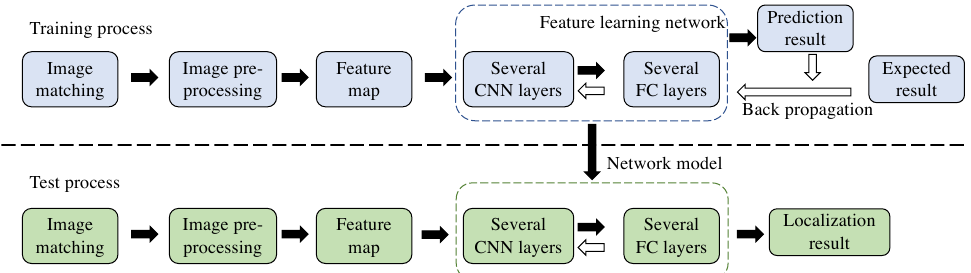
Figure 6. Algorithm training and testing process fusing local and global Figure 4.1.Algorithm training and testing process fusing local and global features